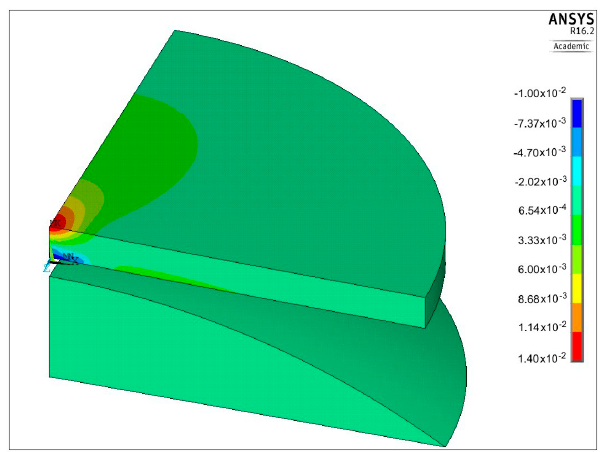
Figure 10. Permanent strains ε x , interpreted as residual ones, obtained after unloading, corresponding to the point number 4 shown in Figure 7.